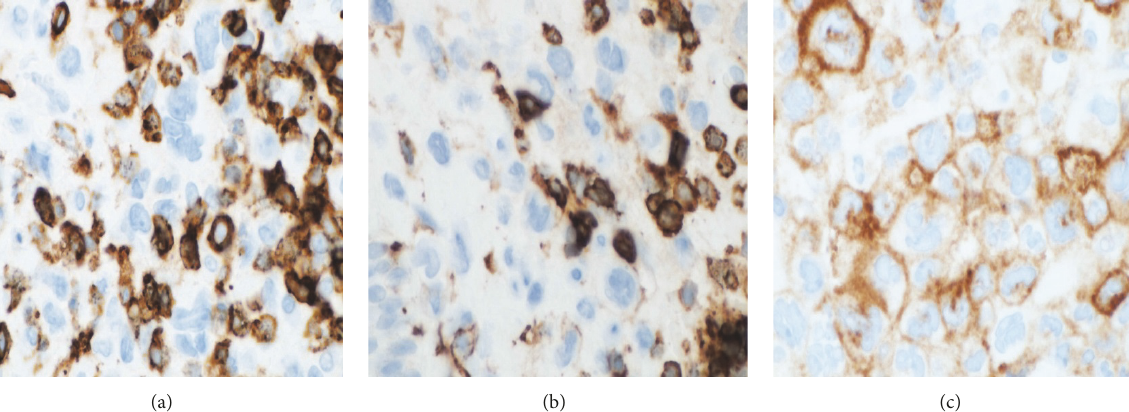
Figure 5: CD45 immunohistochemistry. Biopsies from the first (a) and second site (b) were positive whereas the biopsy from the third site (c) was